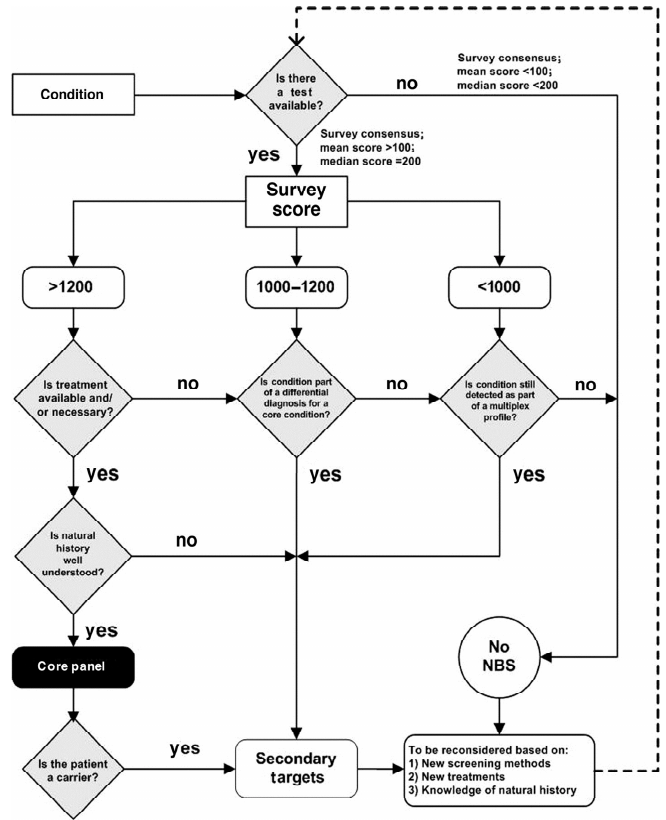
Figure 1. Newborn screening (NBS) algorithm. Reproduced with permission from [18]. Copyright 2006 by the